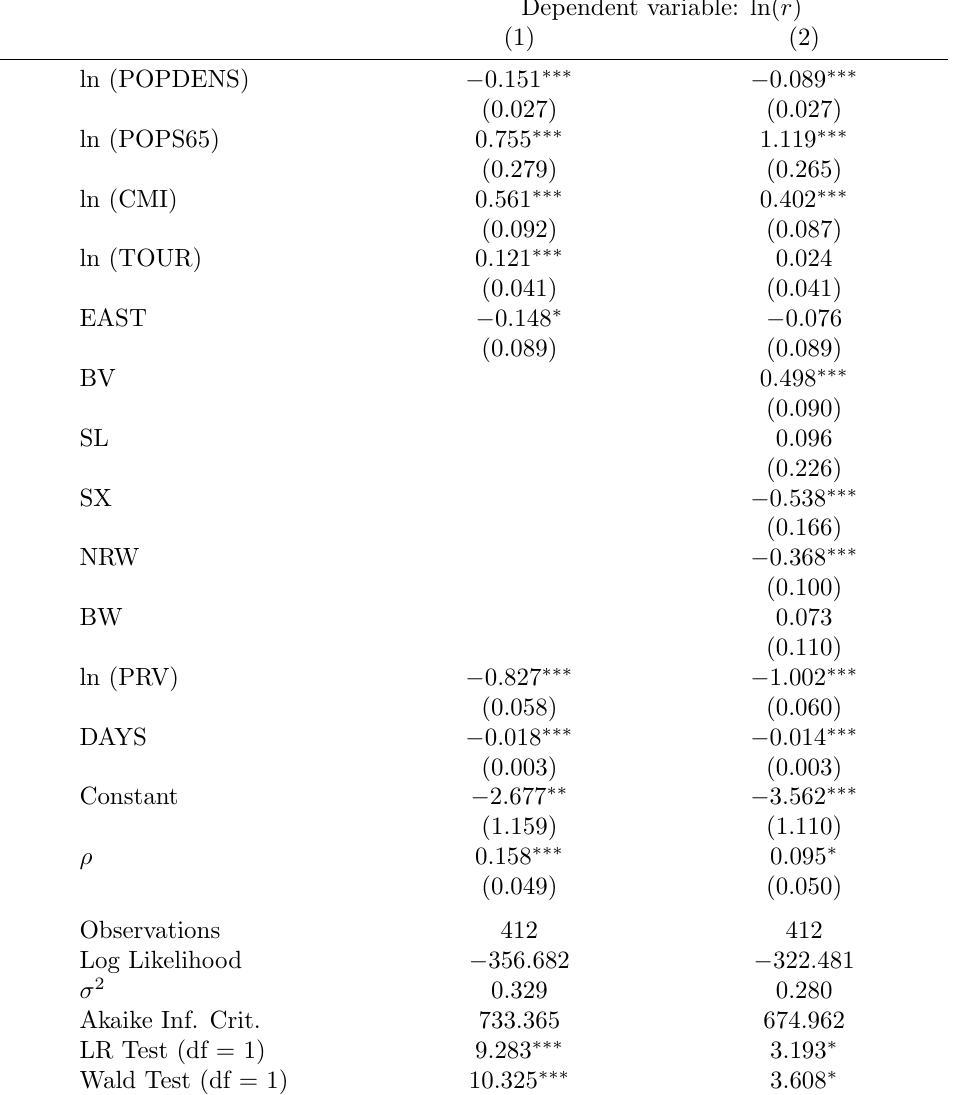
Table 10: Estimation results for the growth rate model (spatial lag model) Dependent variable: ln( r